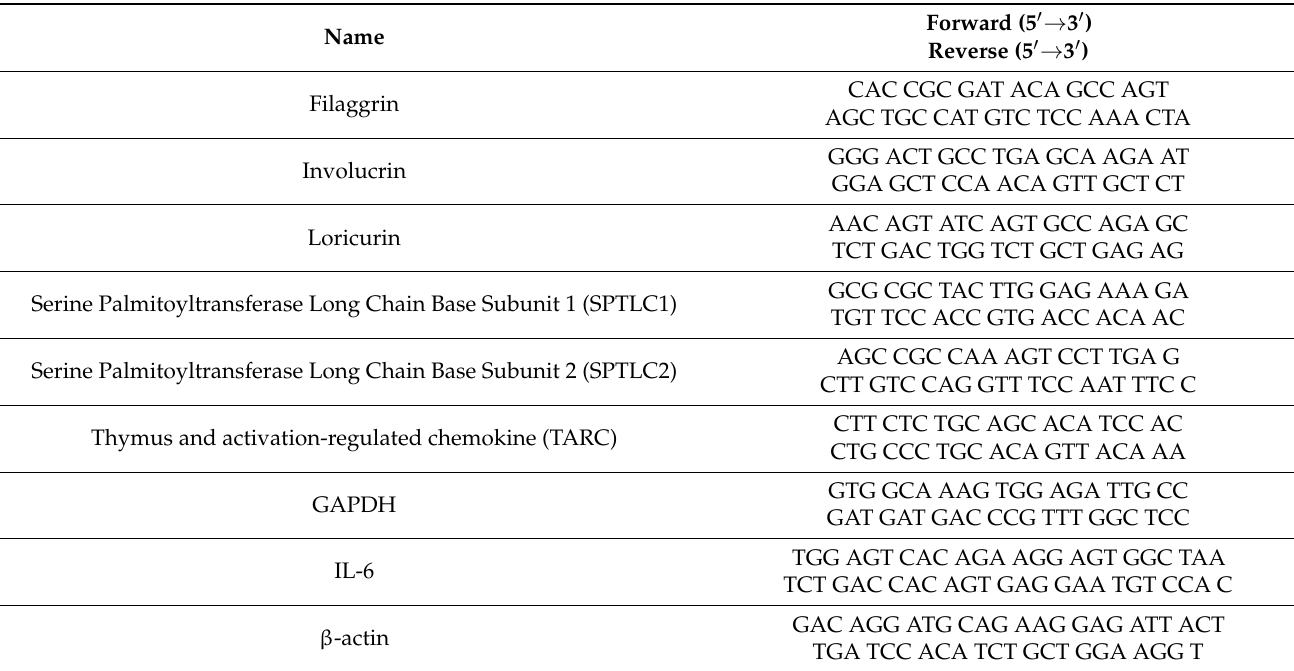
Table 1. List of primers for real-time